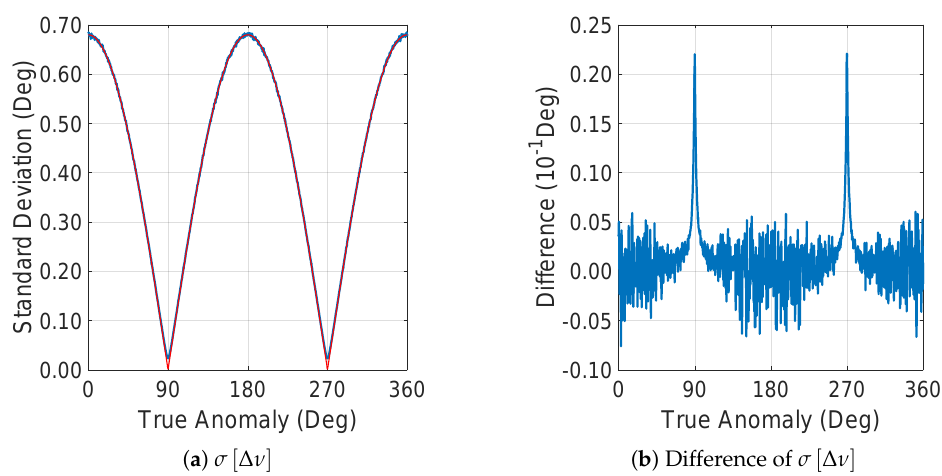
Figure 3. The true anomaly result from measurements between numerical simulation and the analytical approximation model. ( a ) The analytical approximation model (red) fits the numerical simulation (blue) in most areas of true anomaly. However, at certain true anomalies, which are the unique positions of the satellite in its orbit, the difference between the two sets of results increases. ( b ) At around 90 ◦ and 270 ◦ , significant peaks arise for approximately 0.023 ◦ in the standard deviation of ∆ ν .